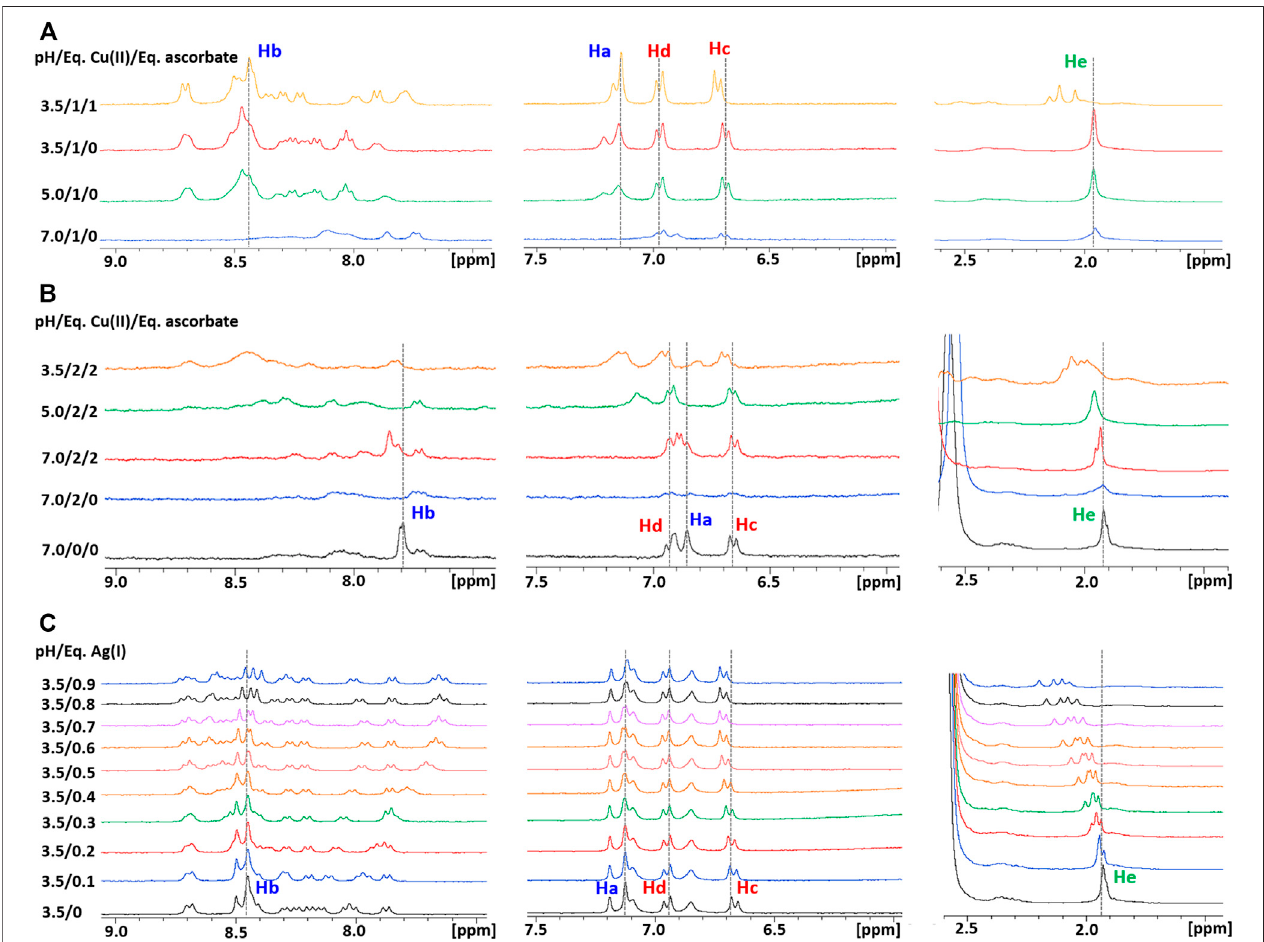
FIGURE 9 | (A) Overlay of three regions of 1D 1 H NMR spectra of Ctr1 1-14 containing 1 eq of Cu(II) in 25 mM Pi buffer at different pH values, with or without ascorbate; the dashed lines indicate the positions ofthe corresponding proton signals at pH 3.5 inthe absenceof ascorbate. (B) Overlay of three regions of1D 1 H NMR spectra ofCtr1 1-14 containing 2eq of Cu(II) in10 mM MES at differentpH values, with or without ascorbate; the dashed lines indicate the positions of thecorresponding protonsignals at pH 7.0 in theabsenceofCu(II). (C) Overlay ofthree regions of1D 1 HNMR spectraof Ctr1 1-14 in25 mM Pibuffer (pH 3.5) at differentAg(I):peptide ratios; the dashed lines indicate the positions of the corresponding proton signals in the absence of